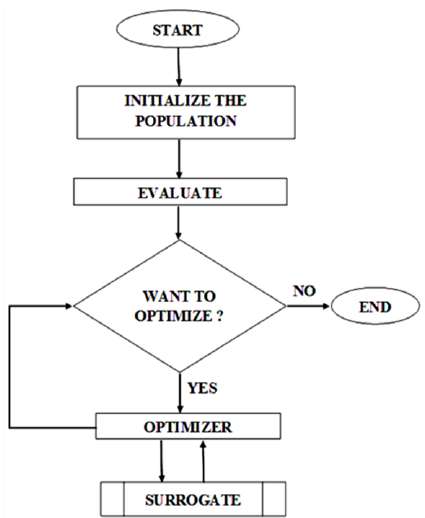
Figure 7. The cycle associated with the surrogate-assisted non-deterministic